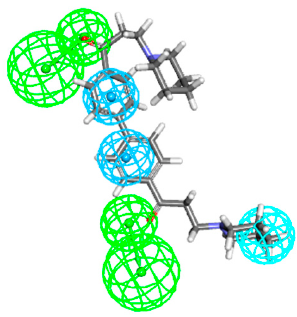
Figure 1. DL0410 showed best alignment with Hypo4 pharmacophore model. Hypo4 consisted of two hydrogen bond acceptors, two ring aromatic features, and one hydrophobic feature.